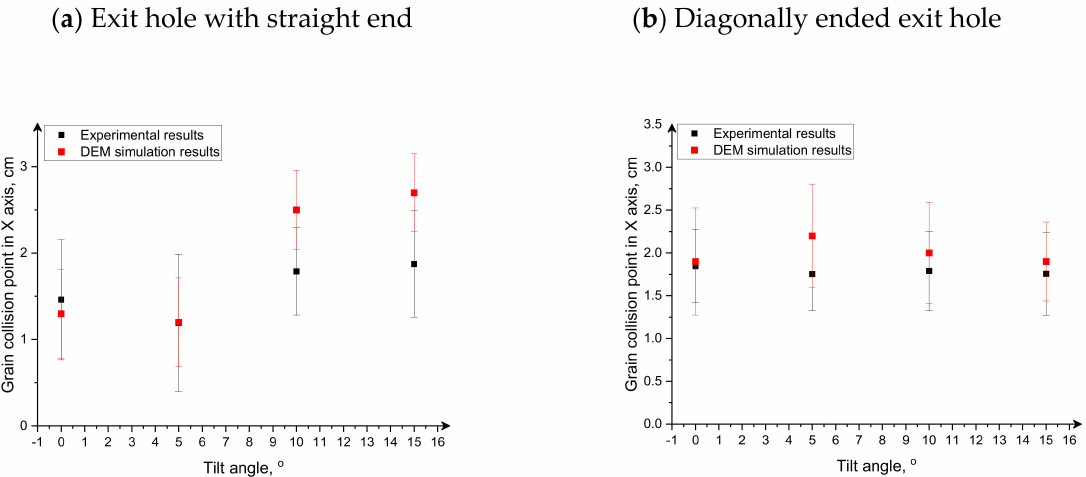
Figure 9. Grain collision point measured in axis X for different tilt angles—experimental and simulation results.